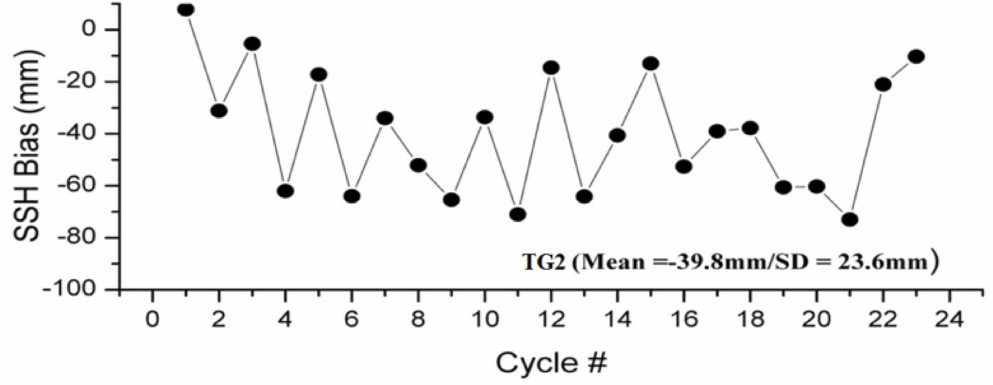
Figure 4. Absolute sea surface height bias of SARAL/AltiKa from cycle 1 to 23 using GDR-T